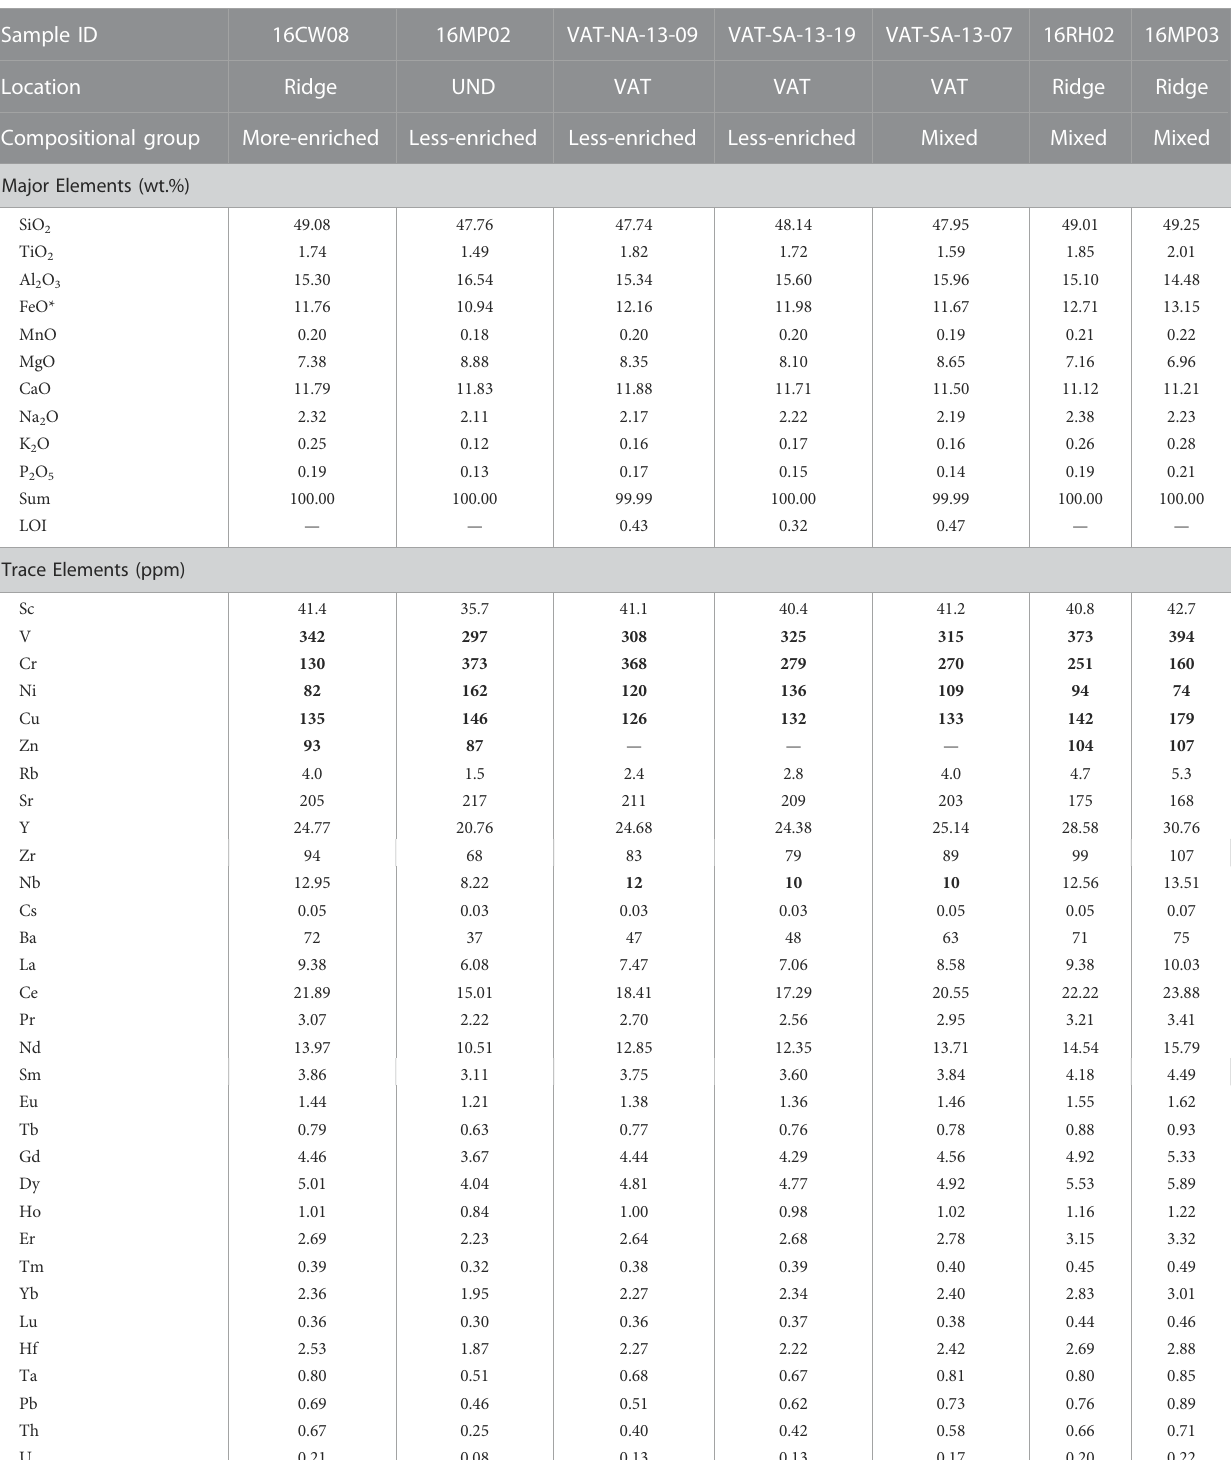
TABLE1GeochemistryofselectedUndirhlíðarridgesamples.Majorelements(inwt.%)andselecttraceelements(bold)measuredbyXRF.Allothertraceelements measured by ICP-MS. Details of analytical methods are described in the text. All samples are whole-rock pillow lavas except 16MP03 (dyke). Location describes sample sites in Undirhlíðar quarry (UND), Vatnsskarð quarry (VAT), or along the ridge between the quarries. Compositional group de fi ned by La N /Sm N value as described in the text. The full geochemical dataset and quality data are available in the (Supplementary